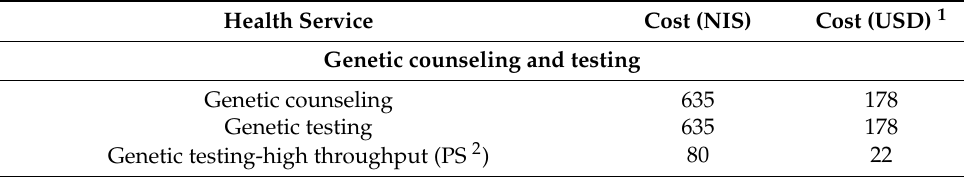
Table 1. Probabilities in decision tree 1 . Table 2. IMOH price list for genetic counseling & testing, surveillance & risk-reducing